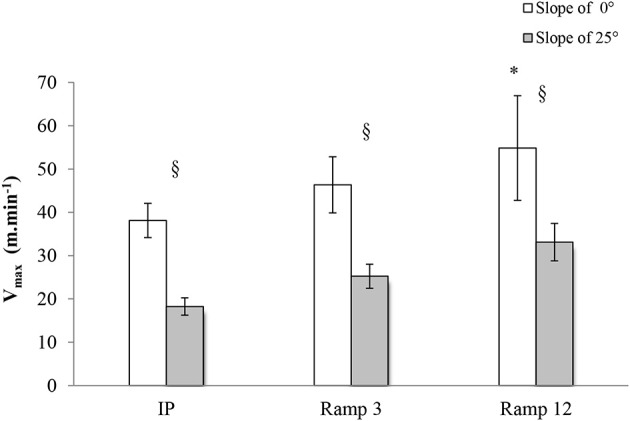
Vmax in each exercise protocol. IP, an incremental protocol with a starting speed of 10 m.min−1 and an increment of 3 m.min−1 every 3 min; Ramp3, a ramp protocol with a starting speed of 3 m.min−1 and an acceleration of 3 m.min−2 (0.05 m.min−1.s−1); Ramp12, a ramp protocol with a starting speed of 3 m.min−1 and an acceleration of 12 m.min−2 (0.2 m.min−1.s−1); §, a significant difference between 25 and 0° for the same protocol (p < 0.05); *, differs significantly from all other protocols (p < 0.05).